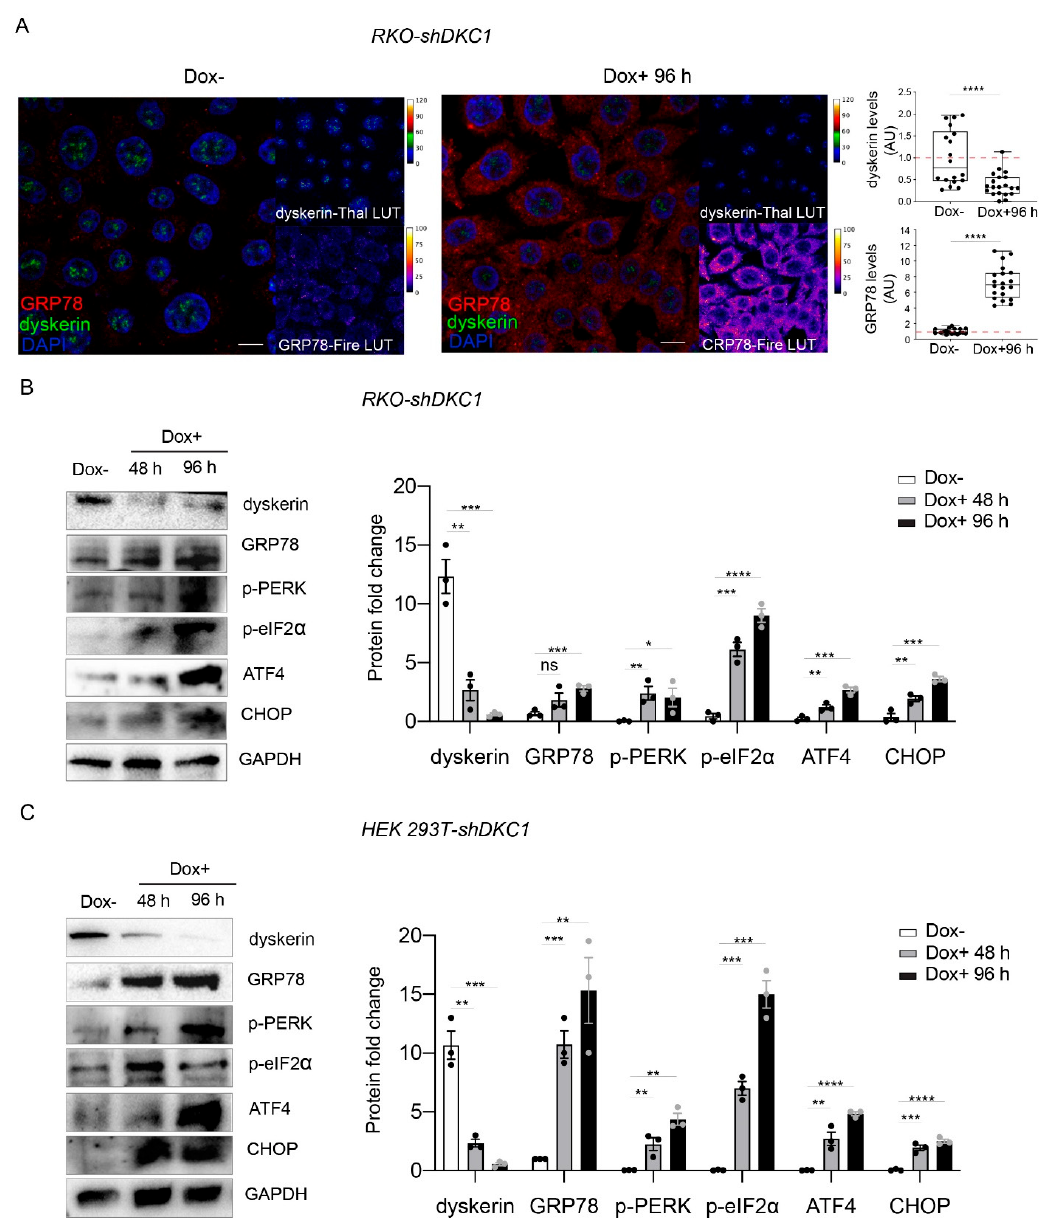
Figure 2. Dyskerin depletion induces ERS and increases UPR markers. ( A ) Confocal images showing the dramatic increase in GRP78/BiP (red or Fire-Lut) expression in RKO-shDKC1 cells treated with Dox for 96 h (Dox+, right panel) compared to untreated control cells (Dox–, left panel). Dyskerin (green or Thal-Lut) downregulation is evident from the strong reduction in the relative signal in Dox+ cells. Nuclei were counterstained with DAPI. GRP78/BiP and dyskerin levels were quantified in multiple cells ( n = 18 RKO-shDKC1 Dox–; n = 20 RKO-shDKC1 Dox+ 96 h), normalized and reported relative to the Dox– condition as mean ± SEM. Scale bars 10 μ m. ( B , C ) Western blot analysis confirming the upregulation of GRP78/BiP and showing the induction of key components of the PERK branch of UPR in RKO-shDKC1 ( B ) and HEK 293T-shDKC1 ( C ) Dox–treated (Dox+) cells for 48 or 96 h. Protein levels were normalized to GAPDH. Data are shown as mean ± SEM ( n = 3). All statistical analyses were performed using an unpaired one-tailed t -test in pairwise comparisons with respect to the Dox– condition (**** p < 0.0001; *** p < 0.001; ** p < 0.01; * p < 0.05; ns, p > 0.05).